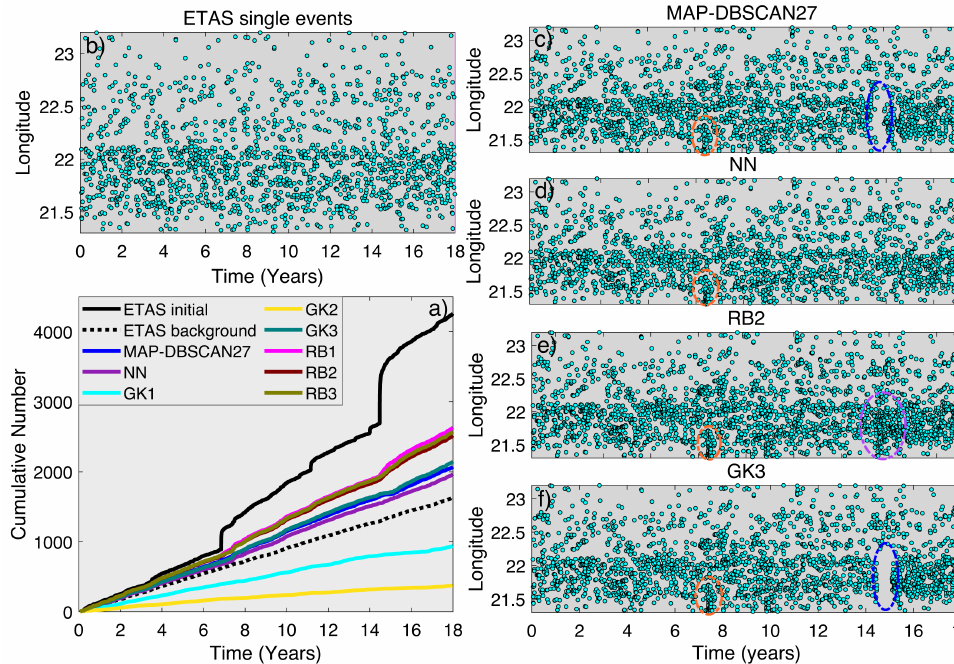
Figure 1. ( a ) Cumulative number of background events for each algorithm, the initial ETAS catalog with black color and the mother events of the ETAS synthetic catalog with the black dotted line. The space-time evolution ( b ) of the initial ETAS catalog and of the background seismicity for the four best algorithms, ( c ) MAP-DBSCAN27 ( J 2 = 0.647), ( d ) NN ( J 2 = 0.727), ( e ) RB2 ( J 2 = 0.630), ( f ) GK3 ( J 2 = 0.676). Colored ellipses stand for large gaps and significant concentration of